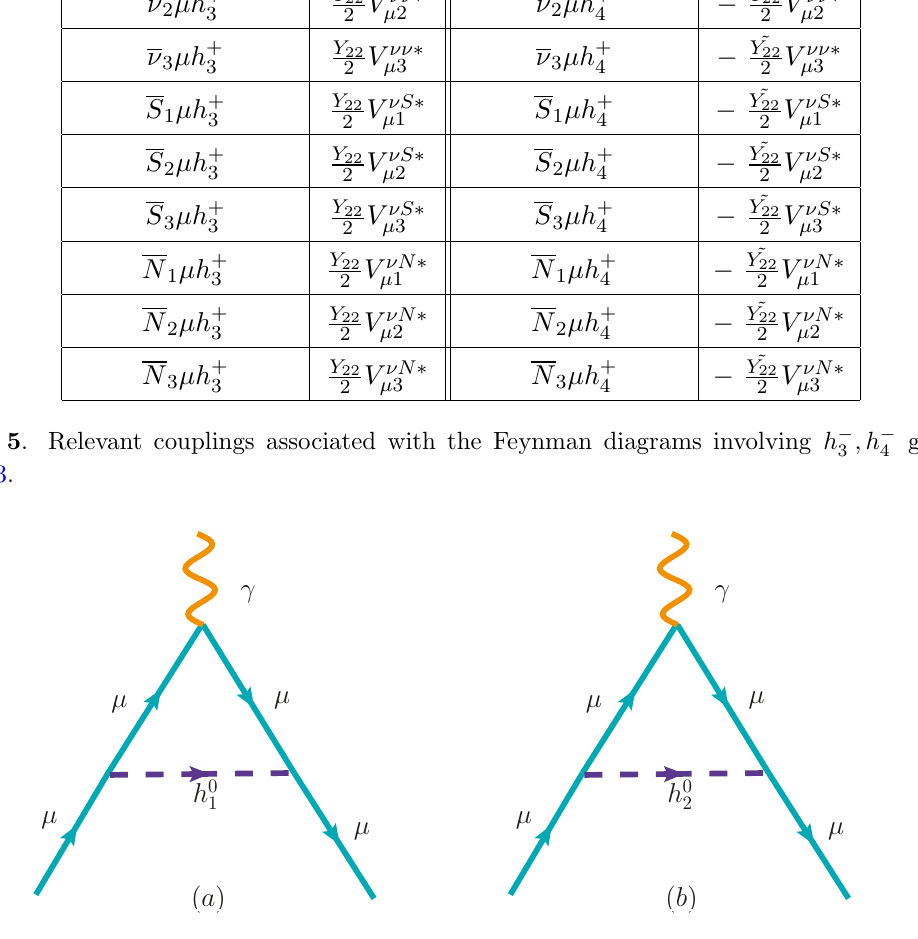
Figure 4 . Feynman diagrams for the interaction of neutral CP-even scalars h 0